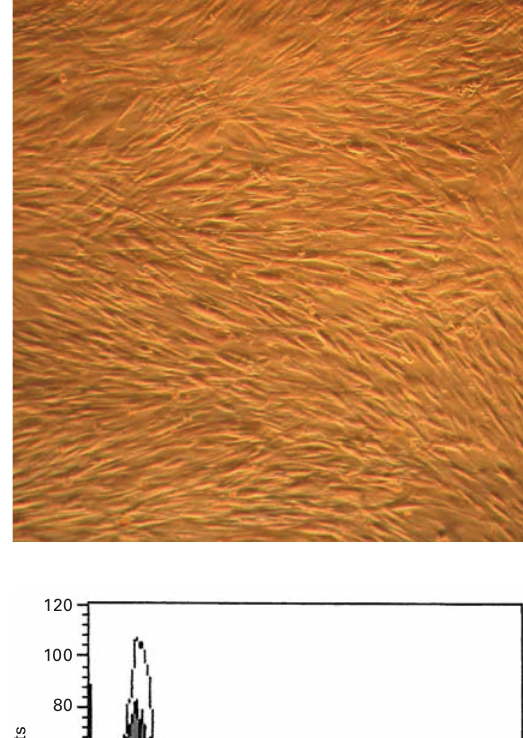
Flow cytometric analysis shows that the mesenchymal stem cells (MSCs) are homogeneous on P3, uniformly pos- itive for the surface proteins of CD29 and CD90, while they are negative for